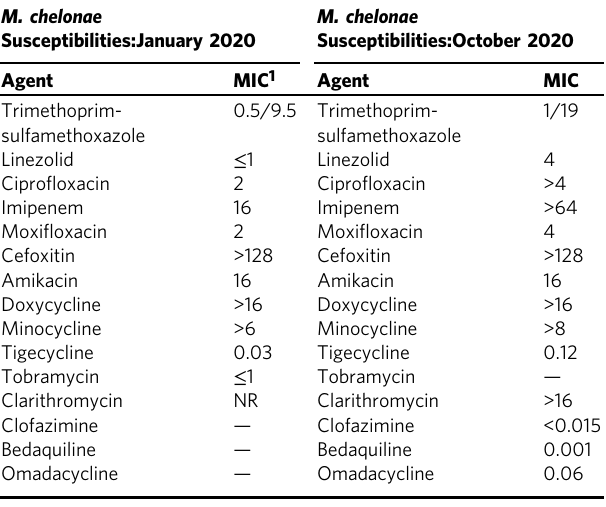
Table 1 Evolution of Mycobacterium chelonae susceptibilities. M.